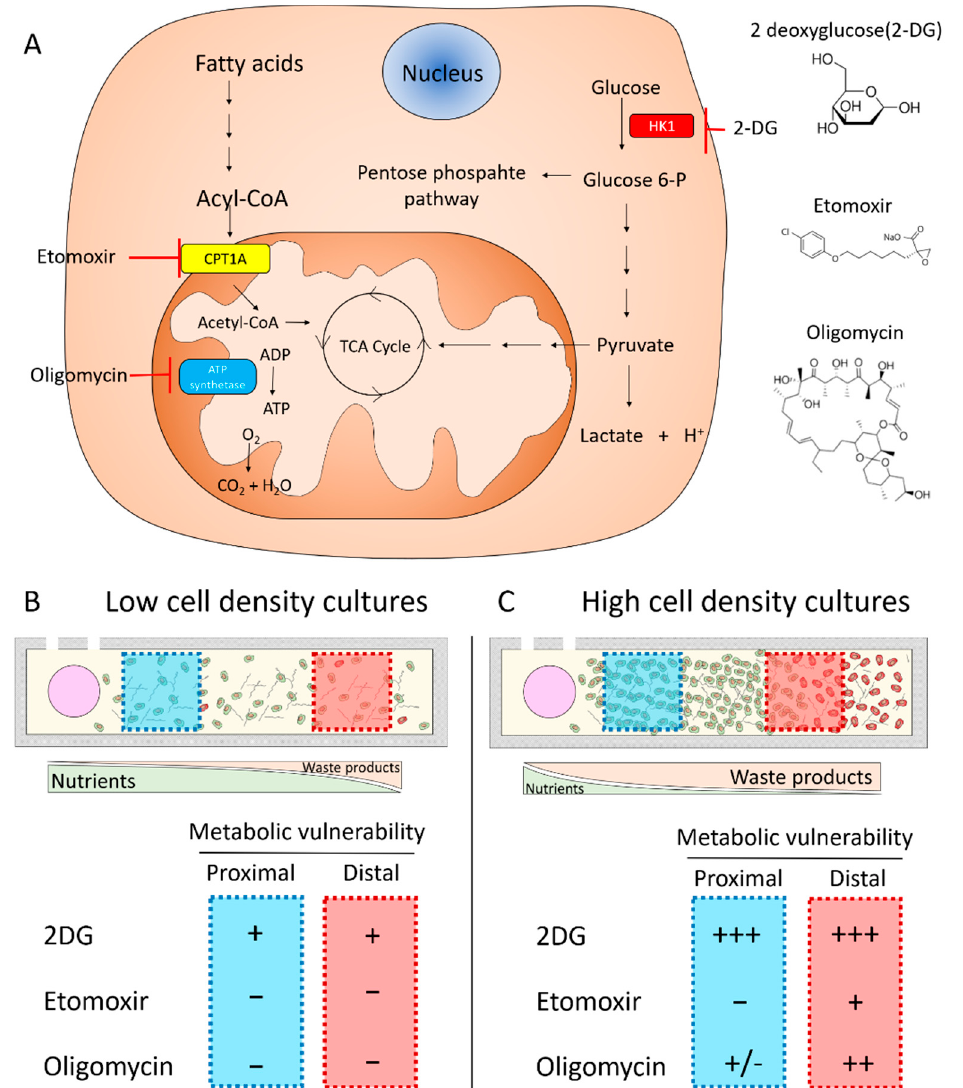
Figure 8. Effect of culture density on tumor metabolic vulnerability. ( A ) Schematic depicting the main targets of the metabolic inhibitors tested. HK: hexokinase, CPT: carnitine palmitoyltransferase, TCA: tricarboxylic cycle. ( B ) When cultured at “low density” (i.e., 3 million cells/mL), MCF7 cells exhibited low sensitivity to metabolic inhibitors. Glycolysis inhibitor 2DG showed a moderate effect on cell viability in the proximal and distal region, whereas etomoxir (i.e., fatty acid oxidation inhibitor) and oligomycin (i.e., ATP synthetase inhibitor) demonstrated no effect. ( C ) In high-density cultures, MCF7 cells showed greater responses to the same metabolic inhibitors. 2DG led to a significant change in optical redox ratio, NAD(P)H τ m , and cell viability. Oligomycin showed a moderate effect, most affecting those cells located in the distal area. Etomoxir led to minor changes in the distal area.